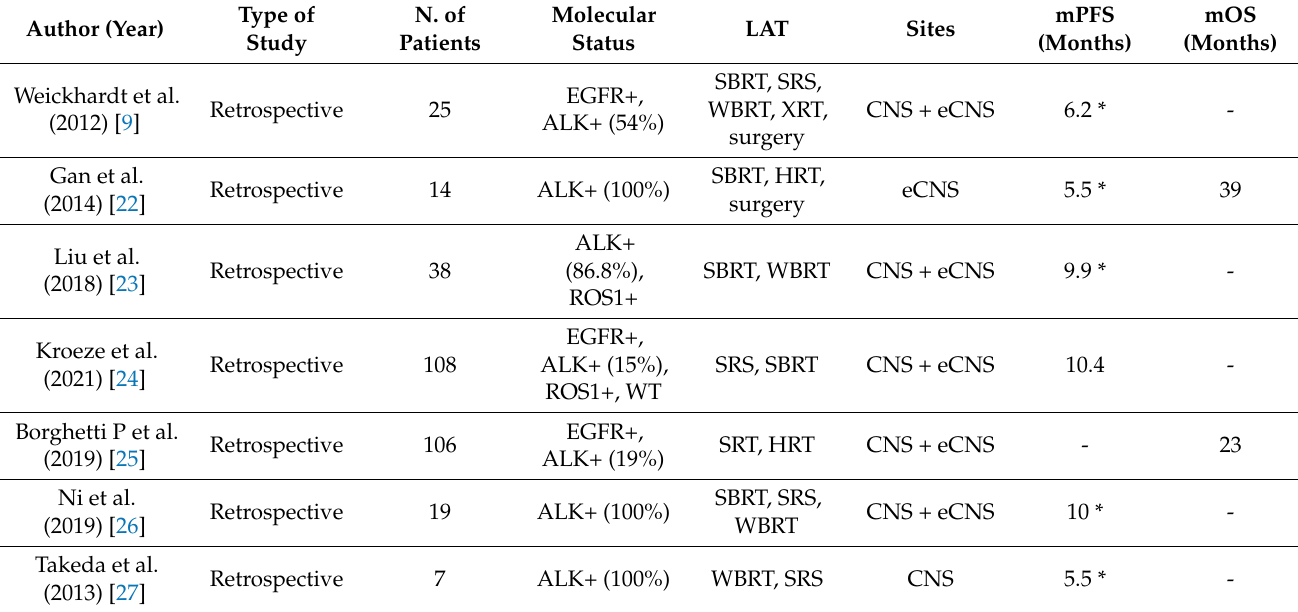
Table 1. Selected trials of oligoprogressive NSCLC patients treated with local ablative therapies combined with